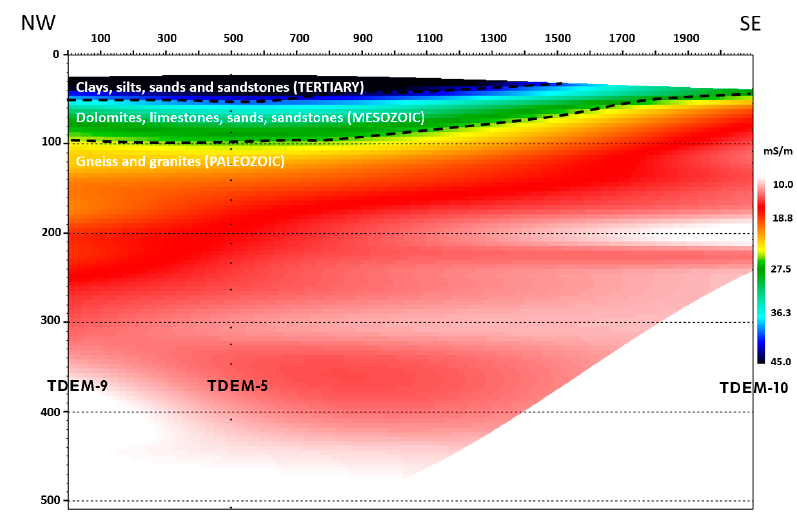
Figure 7. Two-dimensional interpretation of electromagnetic prospecting, TDEM-profile 2.